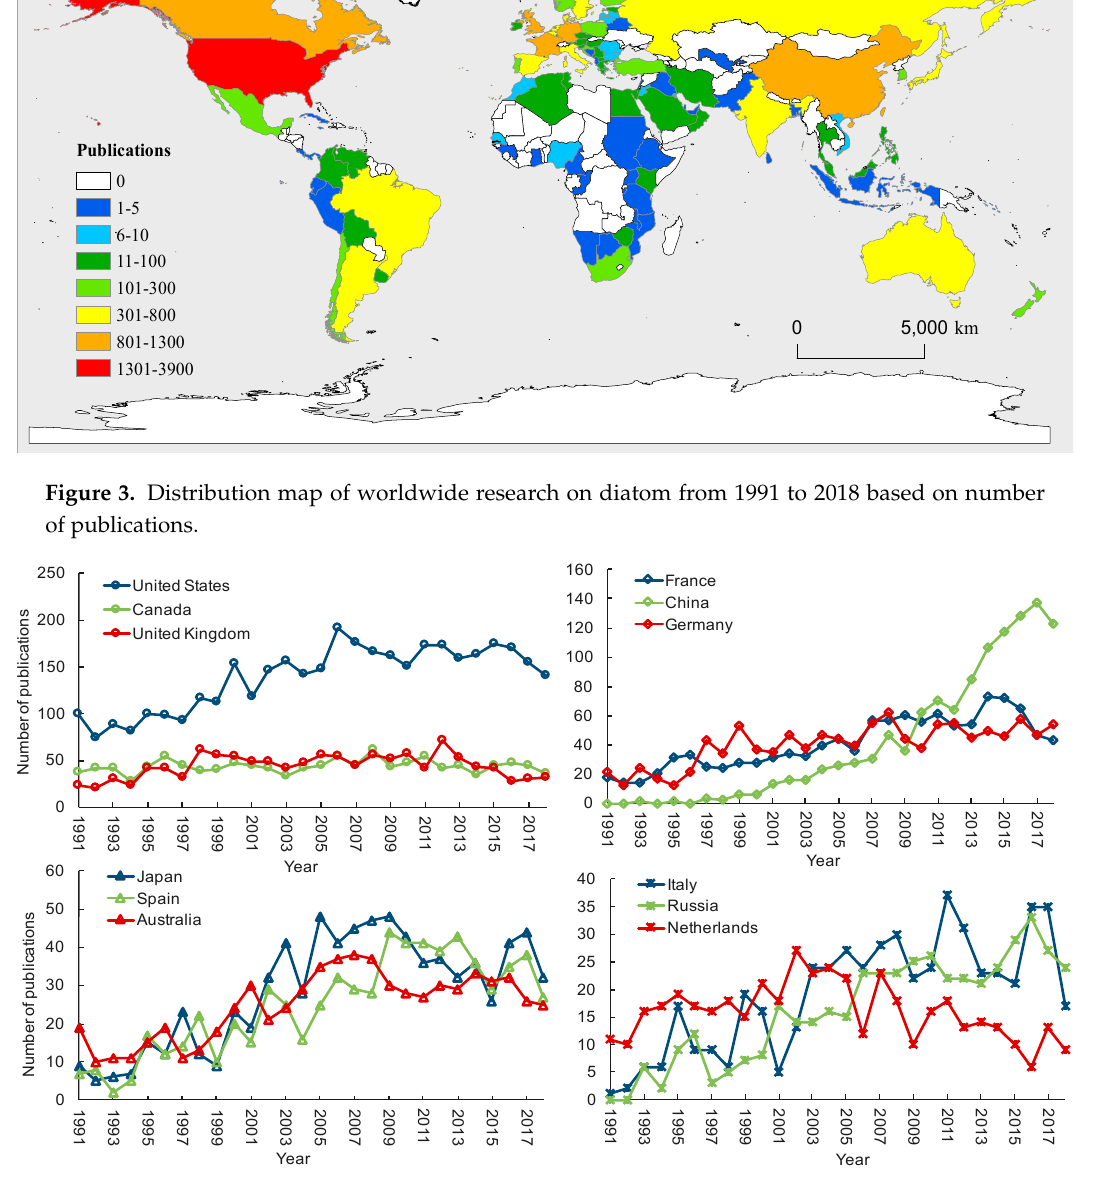
Figure 4. The top 12 countries with most publications related to diatom in title, abstract and keywords during 1991-2018 on Web of Science.